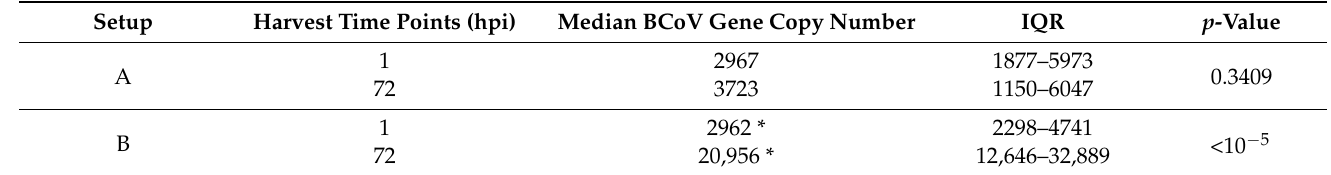
Table 2. Bovine coronavirus (BCoV) gene copy numbers in enteroids at 1 h and 72 h post inoculation (hpi). Samples from Setup A (fragmented enteroids) and B (fragmented and dissociated enteroids), both with n = 9 (3 trials with 3 parallels), were analysed by RT-qPCR using Mann–Whitney test for statistical analysis ( p < 0.05).